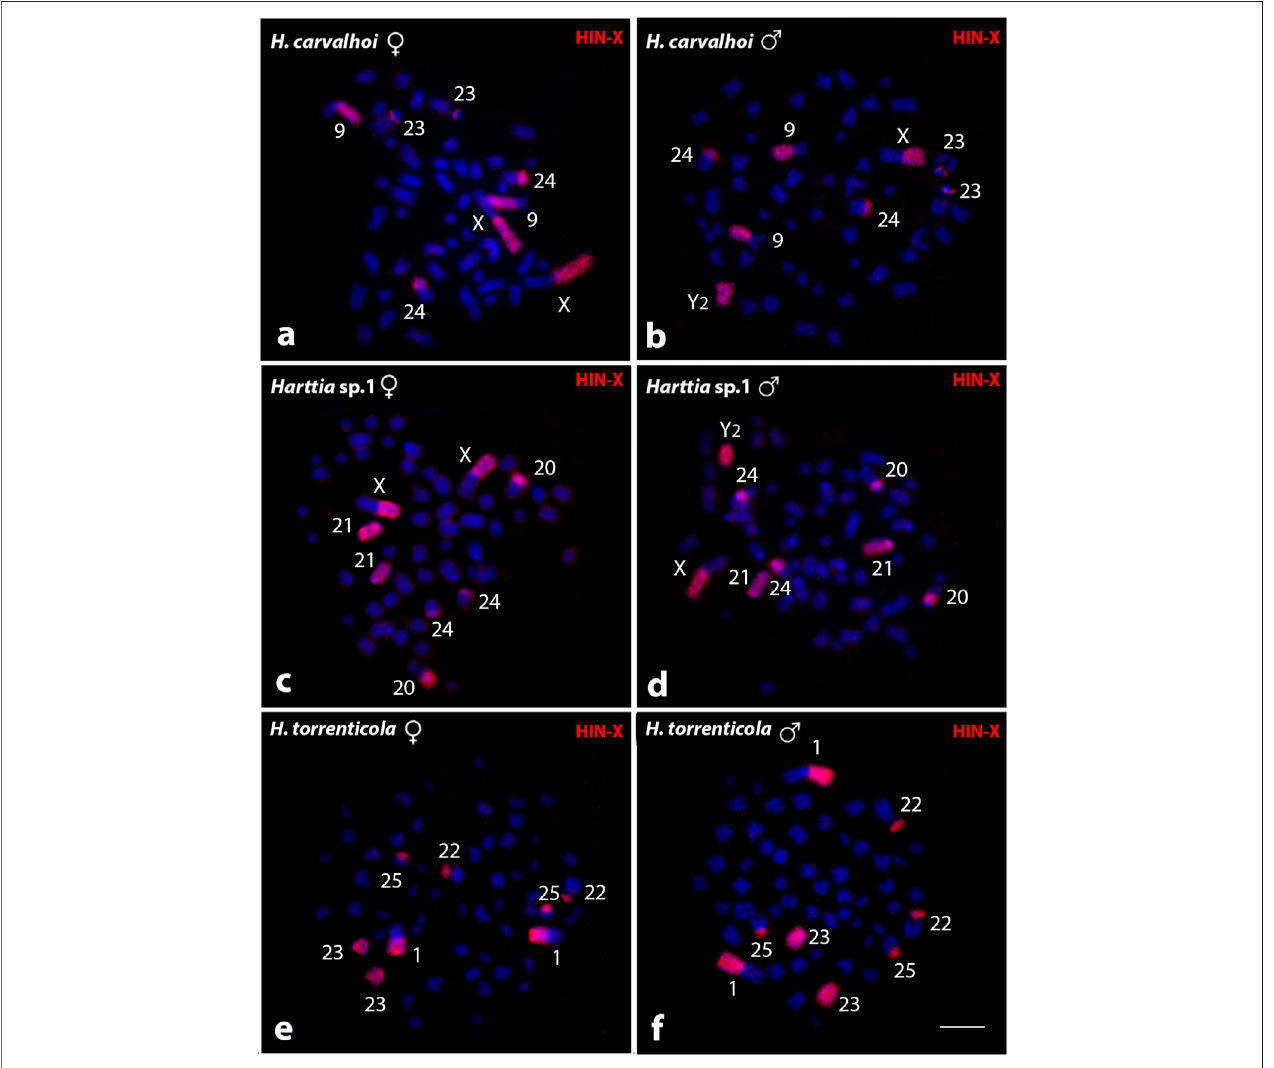
FIGURE 3 | Whole chromosome painting by FISH using the HIN-X probe (red) among Harttia species that shared a large metacentric pair. The numbers of the labeled chromosome pairs are highlighted in the images. In (A, B) metaphases of H. carvalhoi female and male, respectively; (C, D) metaphases of Harttia sp. 1 female and male, respectively; and (E, F) metaphases of H. torrenticola female and male, respectively. Bar = 5 µm.